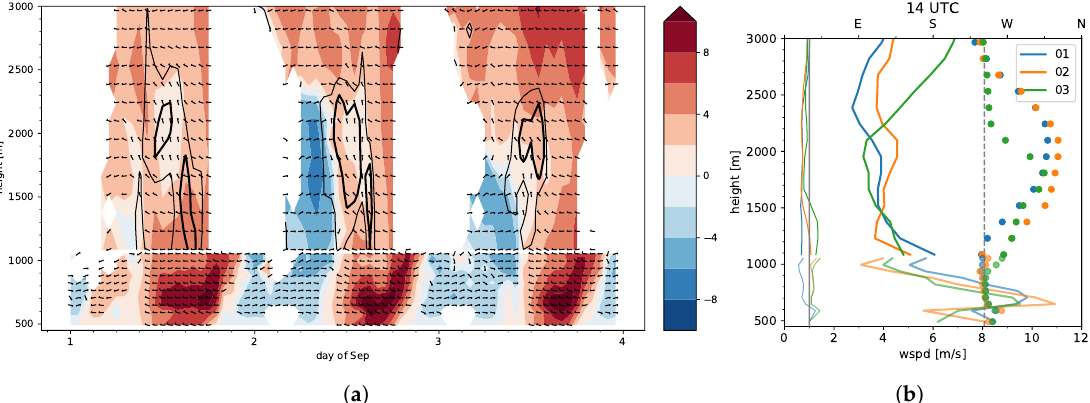
Figure 14. ( a ): Time–height cross-section of along-valley wind speed (color) and wind direction (barbs) with respect to the valley’s axis for high-mode wind profiler data (for height > 1100m MSL) combined with low-mode wind profiler and weather station data for the first three days of September 2016. Bold and thin contour lines denote vertical velocity with contour values of − 0.4ms − 1 and − 0.2ms − 1 , respectively. ( b ): Profiles of wind speed (bold lines), wind direction (symbols), and vertical velocity (thin lines) for the first three days of September 2016 for the high- (height > 1100m MSL) and low-mode wind profiler. The solid grey line marks the zero line for vertical velocity, and the dashed grey line marks the valley’s